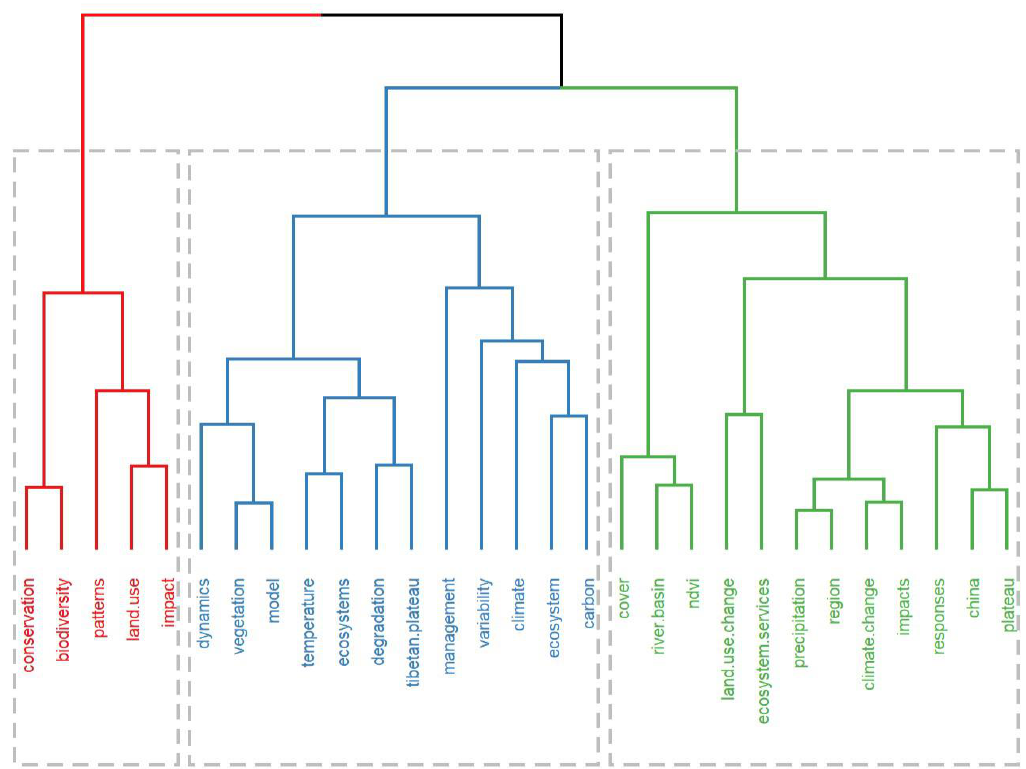
Figure 10. Hierarchical cluster analysis of keywords relating to the ecological and environmental effects of land use and cover changes (LUCC) on the Qinghai – Tibetan Plateau (QTP).